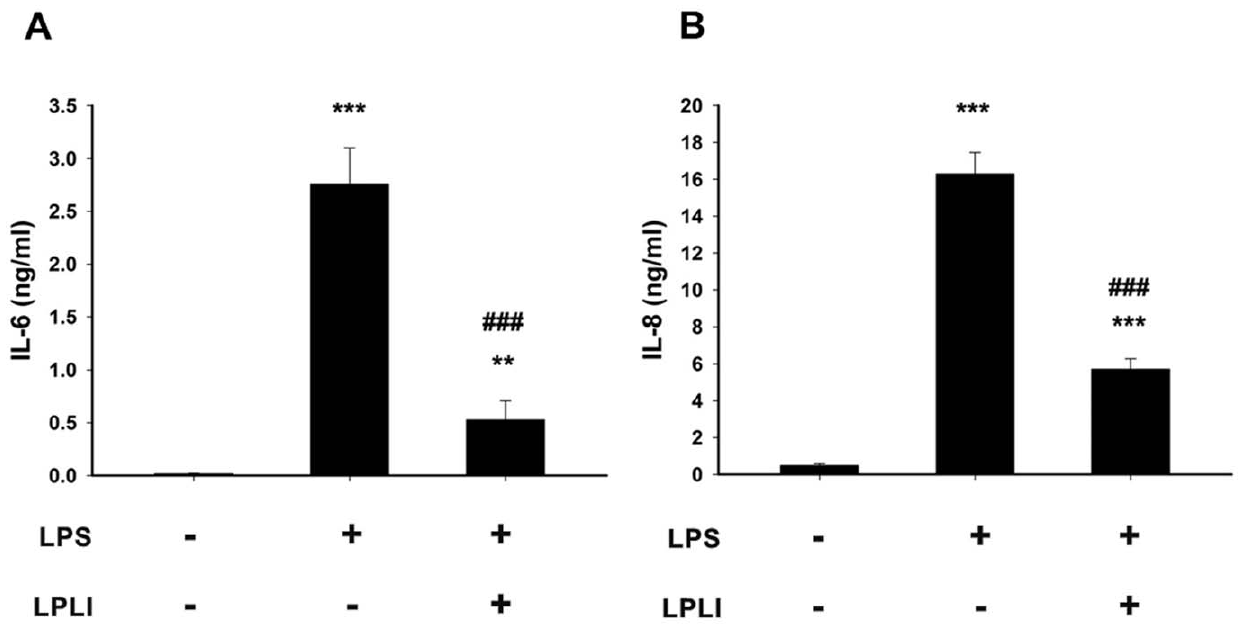
Figure 3. LPLI inhibits protein secretion of IL-6 and IL-8. The levels of pro-inflammatory proteins in LPS-stimulated hADSC culture media at 24 hours were determined by ELISA. ( A ) IL-6. ( B ) IL-8. The data are shown as the mean 6 SD (n=8). The following statistical levels were applied: **p , 0.01 and ***p , 0.001 compared to the control and ### p , 0.001 compared to LPS (50 ng/ml).